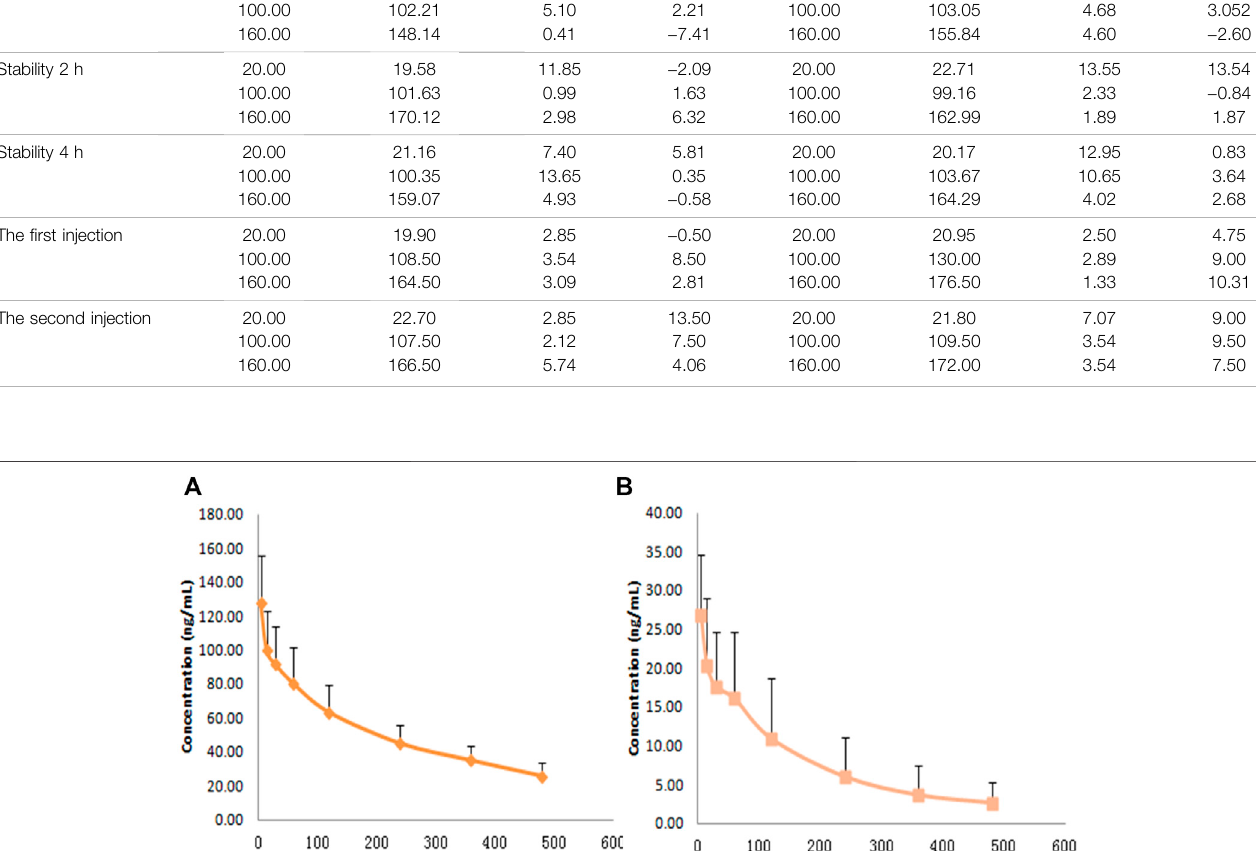
Frontiers in Chemistry |